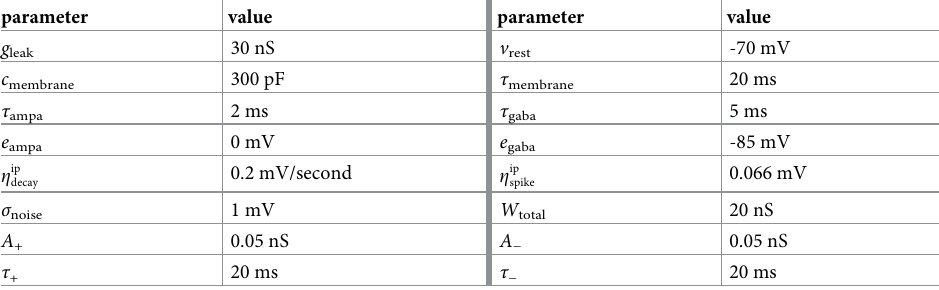
Table 1. Shared simulation parameters. parameter value parameter value 30 nS -70 mV